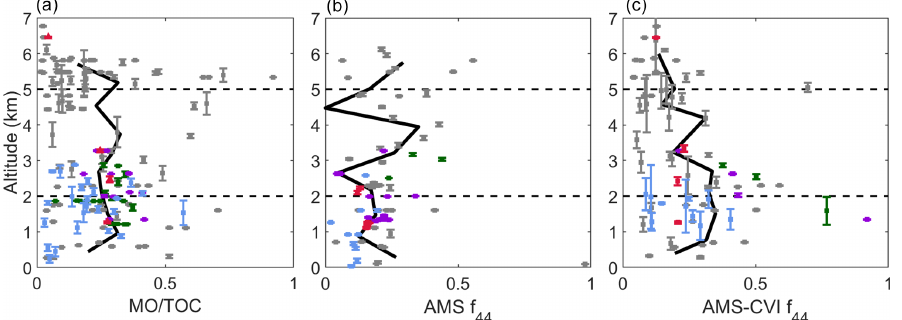
Figure 4. Vertical profile of (a) the ratio of C mass from measured organics (MO) to TOC for cloud water samples, (b) AMS f 44 in cloud-free air and (c) AMS-CVI f 44 in cloudy air. AMS data in panel (b) correspond to cloud-free periods that were spatially and temporally adjacent to the collected cloud water samples, while the data in panel (c) are within the period of cloud water collection times in cloud. Colors in panels (a) , (b) , and (d) represent the same case study points as in Fig. 3: North (green), East (purple), Biomass Burning (red), Clark (blue), and non-case points (gray). The black lines in panels (a) , (b) , and (d) represent locally weighted average